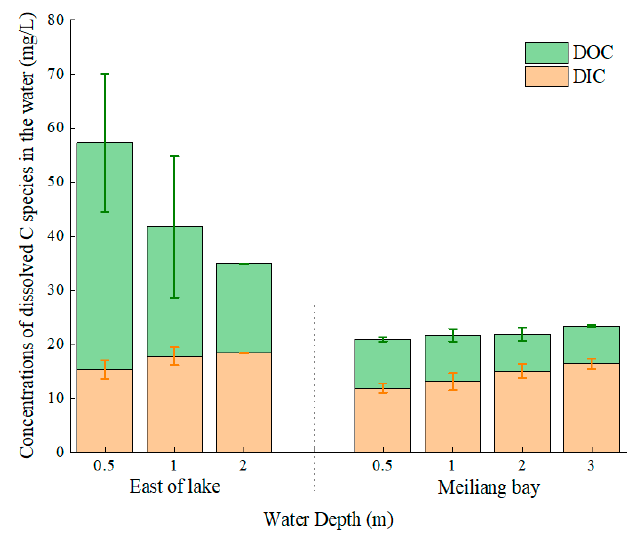
Figure 3. Dissolved C species in the water layers of Taihu Lake.